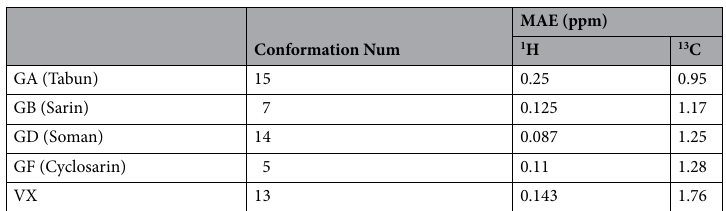
Table 1. The number of conformational isomers of each nerve agent and the average MAE of 1 H and 13 C NMR between experimental and predicted data (all conformations are considered with Boltzmann